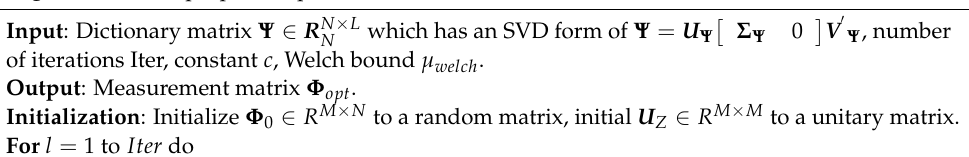
Algorithm 1. The proposed optimization